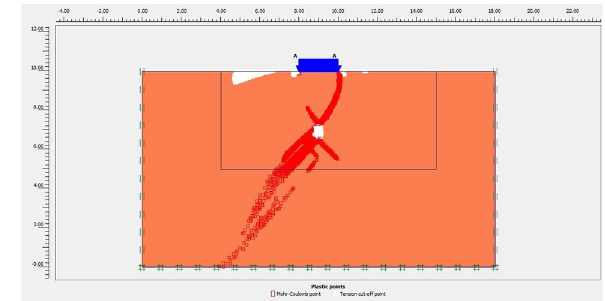
Fig. 26 Plastic points changes for the failed soil with 3% gasoline